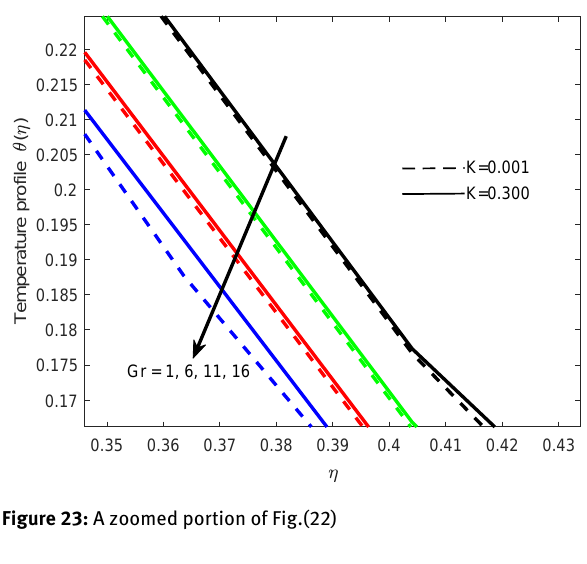
Figure 23: A zoomed portion of